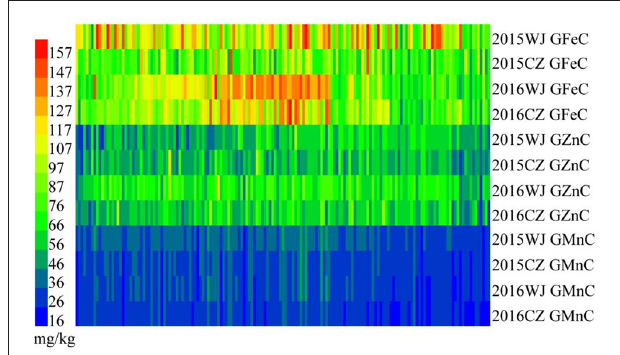
FIGURE 1 | Heat map of GFeC, GZnC, and GMnC of the advanced lines grown at 2015WJ, 2015CZ, 2016WJ, and 2016CZ.